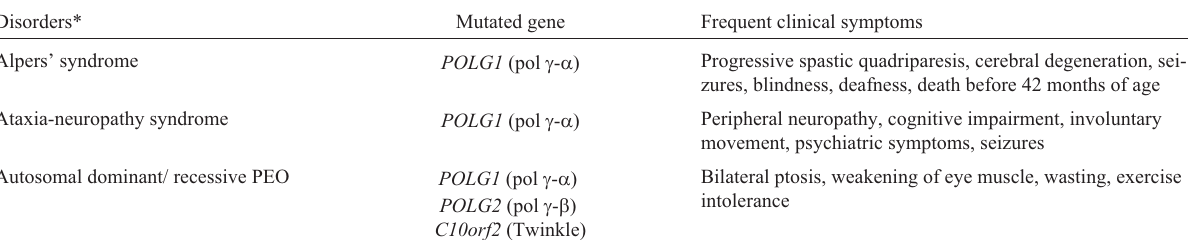
Table 1 - Mutated mtDNA replication genes and associated human mitochondrial